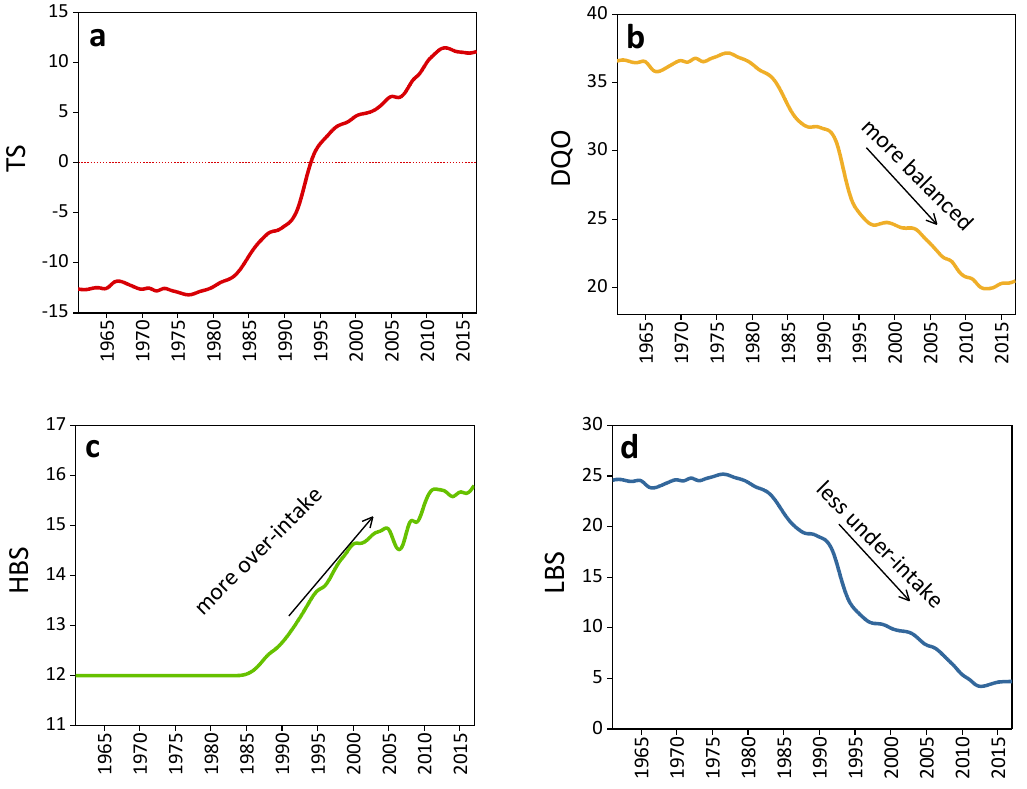
Figure 3. Evaluation the Chinese diet from 1961 to 2017 using NDBI system. ( a )Total score; ( b ) diet quality distance; ( c ) high bound score; ( d ) low bound score.